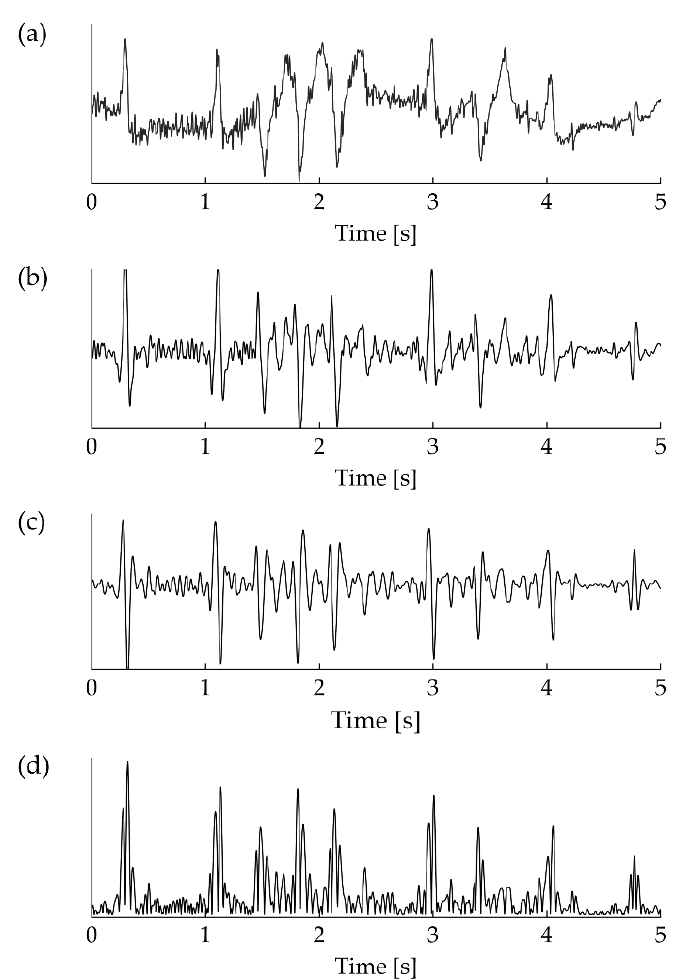
Figure 6. Stages of the detection process. ( a ) Raw input ECG signal, plagued by baseline wander and network interference. ( b ) Noise rejection with the application of MAC(0.02, 0.008)–MAC(0.12, 0.024). ( c ) Derivative of the signal resulting from the application of the selected dMAC. ( d ) Rectification of the derivative.